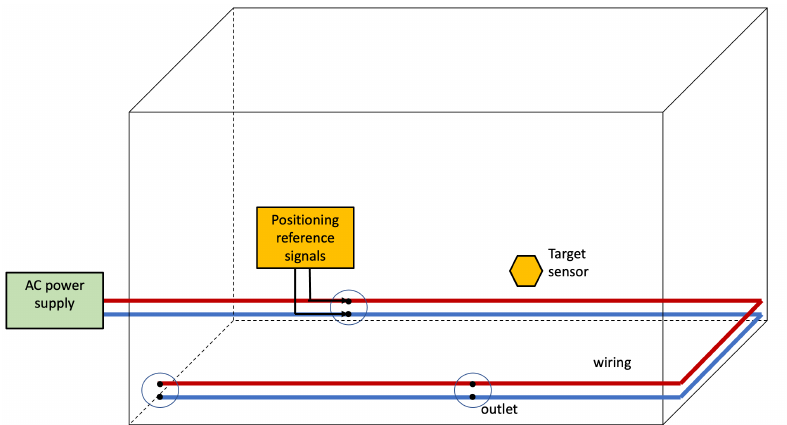
Figure 8. Infra-based and Target-based PLPS architecture. The PLPS components are highlighted in yellow. In this scenario, the electrical network and the target collaborate to obtain the position